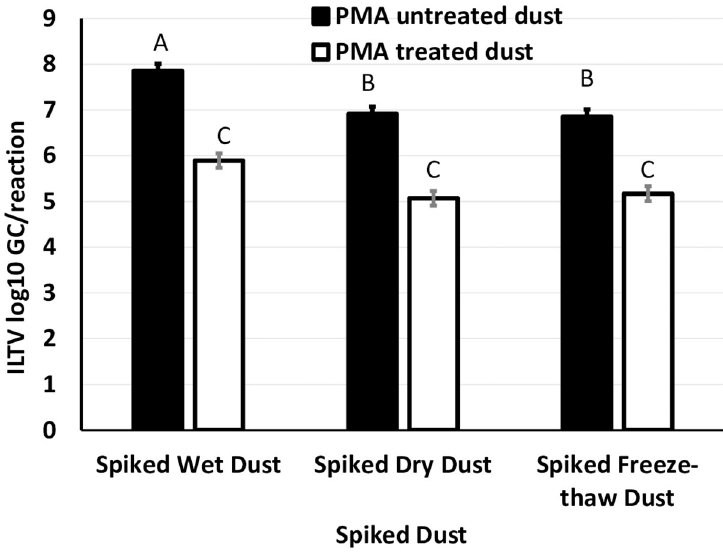
Fig 3. Effect of PMA pre-treatment on ILTV GC recovered from spiked dust samples subjected to three different treatments. Dust was spiked with ILTV at a concentration of 400 TCID 50 and either reconstituted in cell medium immediately (Nil) or dried at 30˚C for 24h (Dried) or dried and subjected to two freeze-thaw cycles (Dried and freeze- thaw). Superscripts ( ABC ) not sharing the same letter denote difference (p < 0.05) between samples.